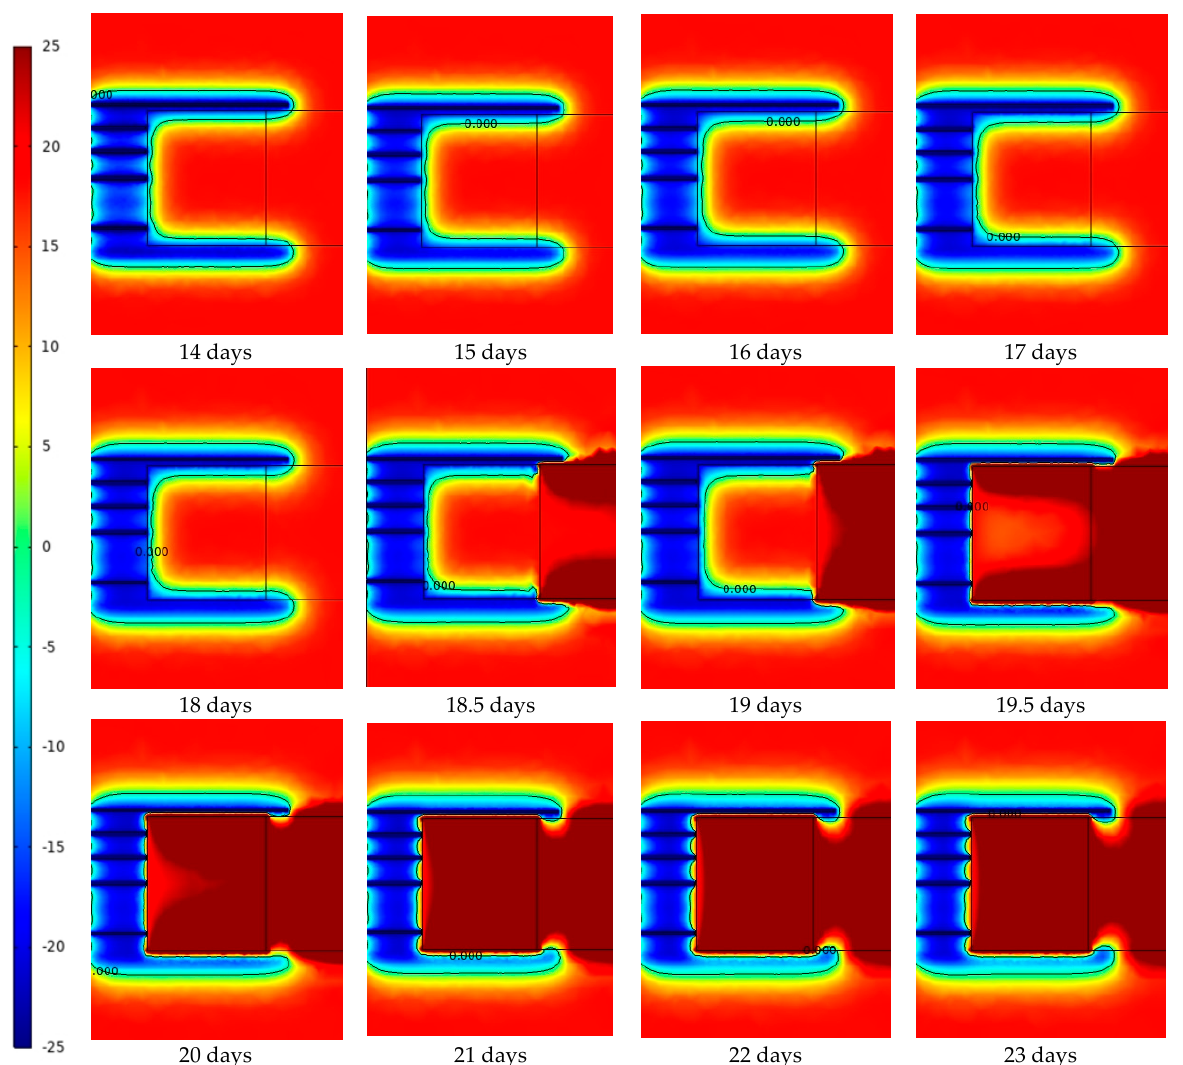
Figure 10. Temperature cloud map in Section 1.